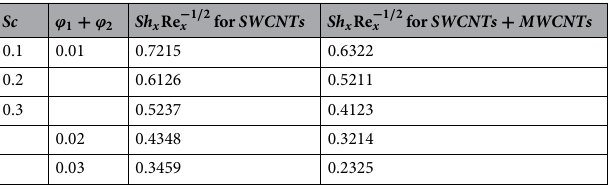
Table 5. Impact upon Sherwood number regarding different values of emerging parameters.